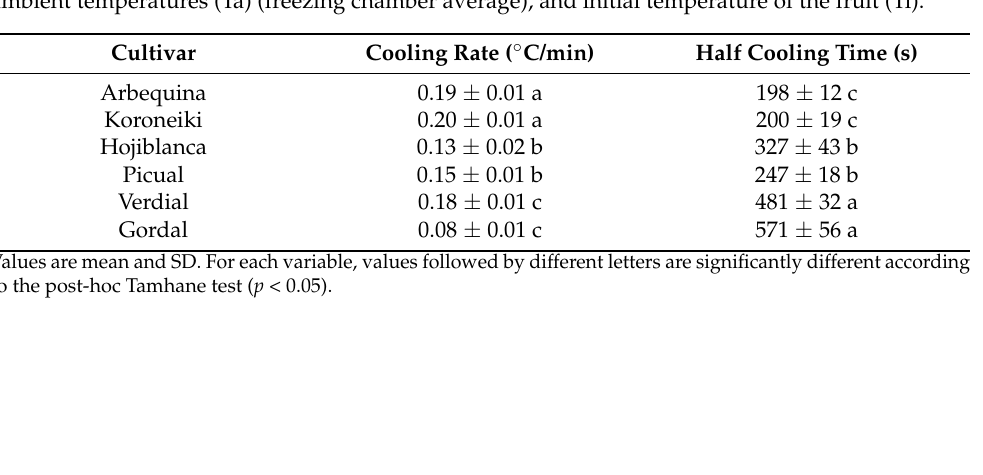
Table 2. Cooling Rate (CR) and half cooling time (z) of six different samples of olives for different ambient temperatures (Ta) (freezing chamber average), and initial temperature of the fruit (Ti).